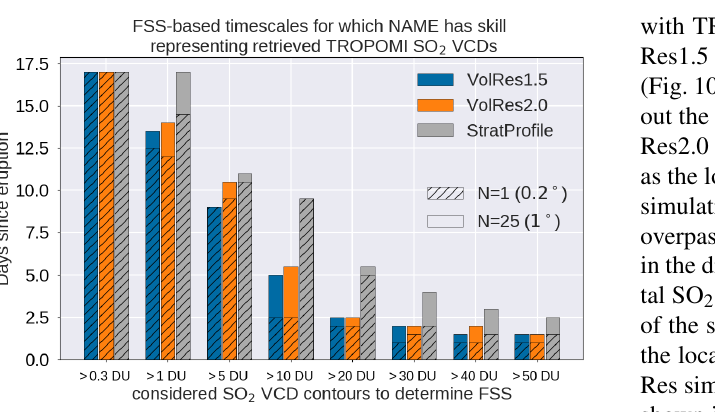
Figure 9. The timescales for which the NAME model shows skill based on the FSS, when compared with TROPOMI retrievals. The results are shown for the three simulations as discussed in Sect. 2.3.4 and for two different neighbourhood sizes (value in brackets represent the corresponding resolution). The FSS metric is calculated only for the first 17d of the simulation (up to 10 July), as the SO 2 VCD values become too small after to give a good estimate of the FSS from the TROPOMI